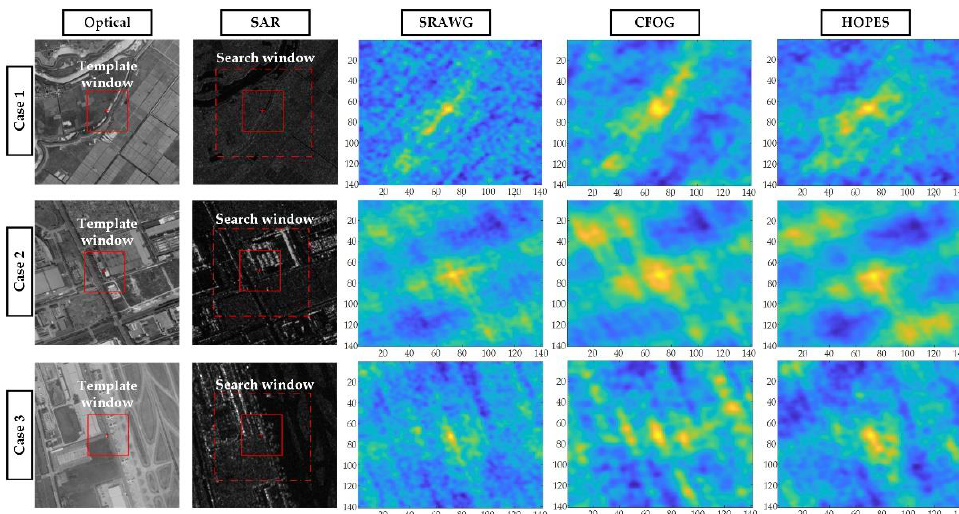
Figure 12. SSD search surfaces for three descriptions.